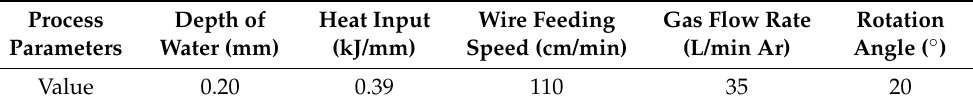
Table 2. Process parameters of comparative experiment between UWLD and IWLD. Process